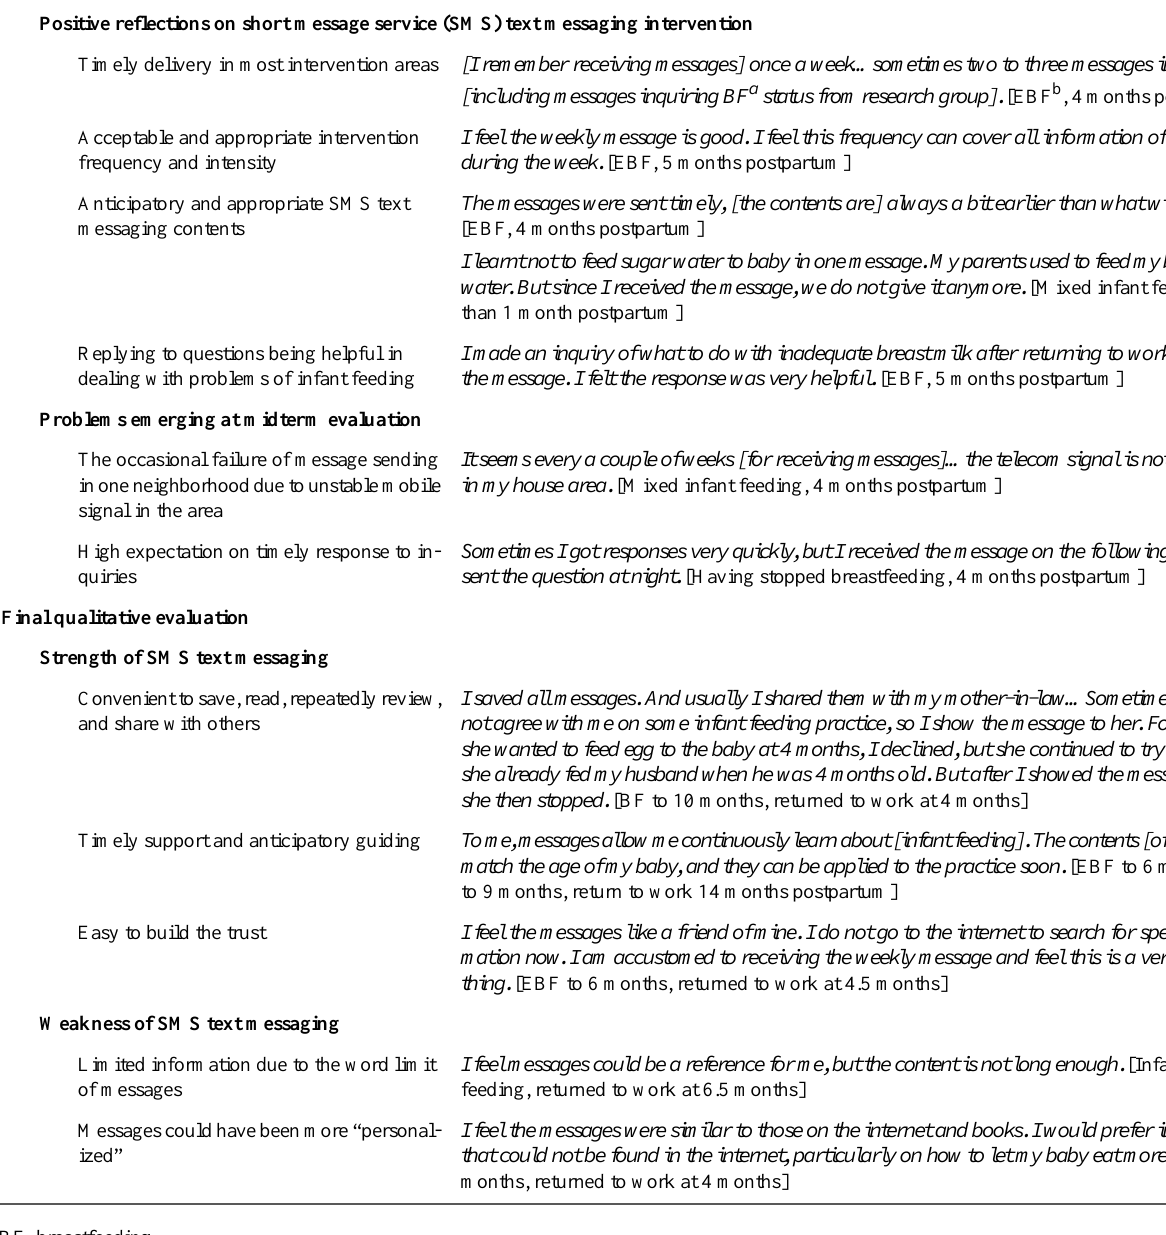
Table 1. Themes and selected quotes from the process evaluation. Midterm